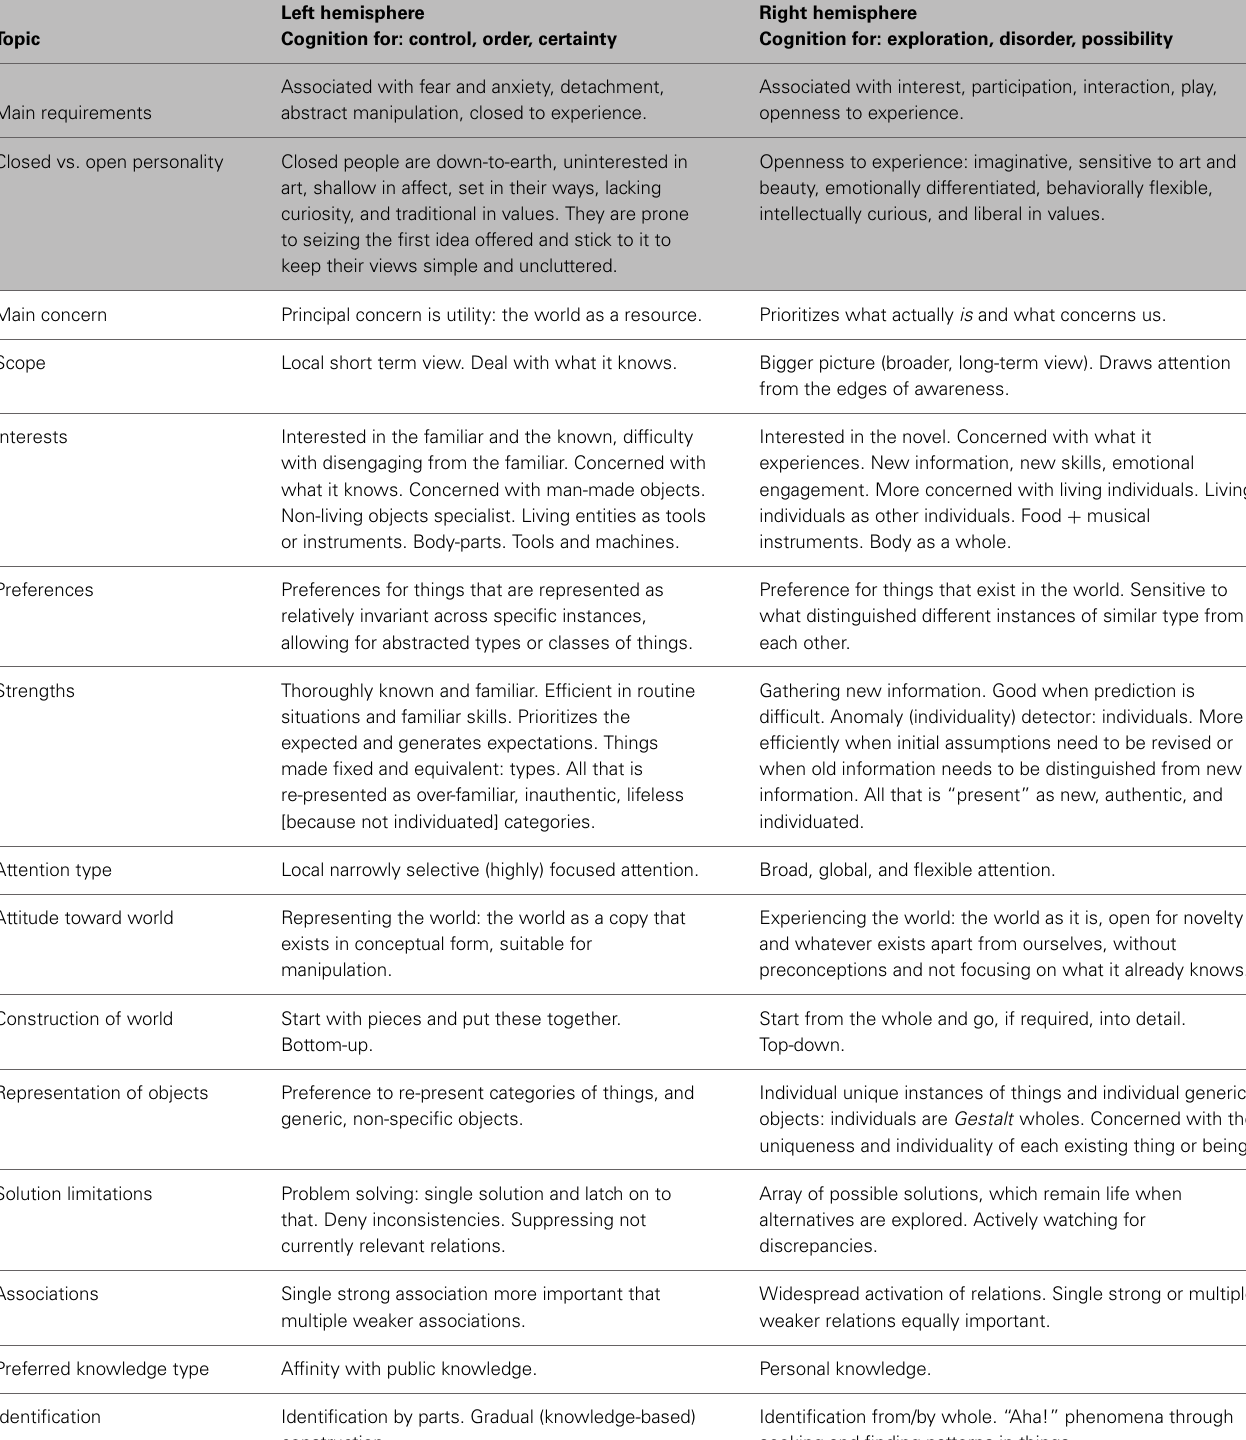
Table 1 | Overview of roles and approaches ascribed to the left and right cortical hemisphere that together define two quite different stances toward the